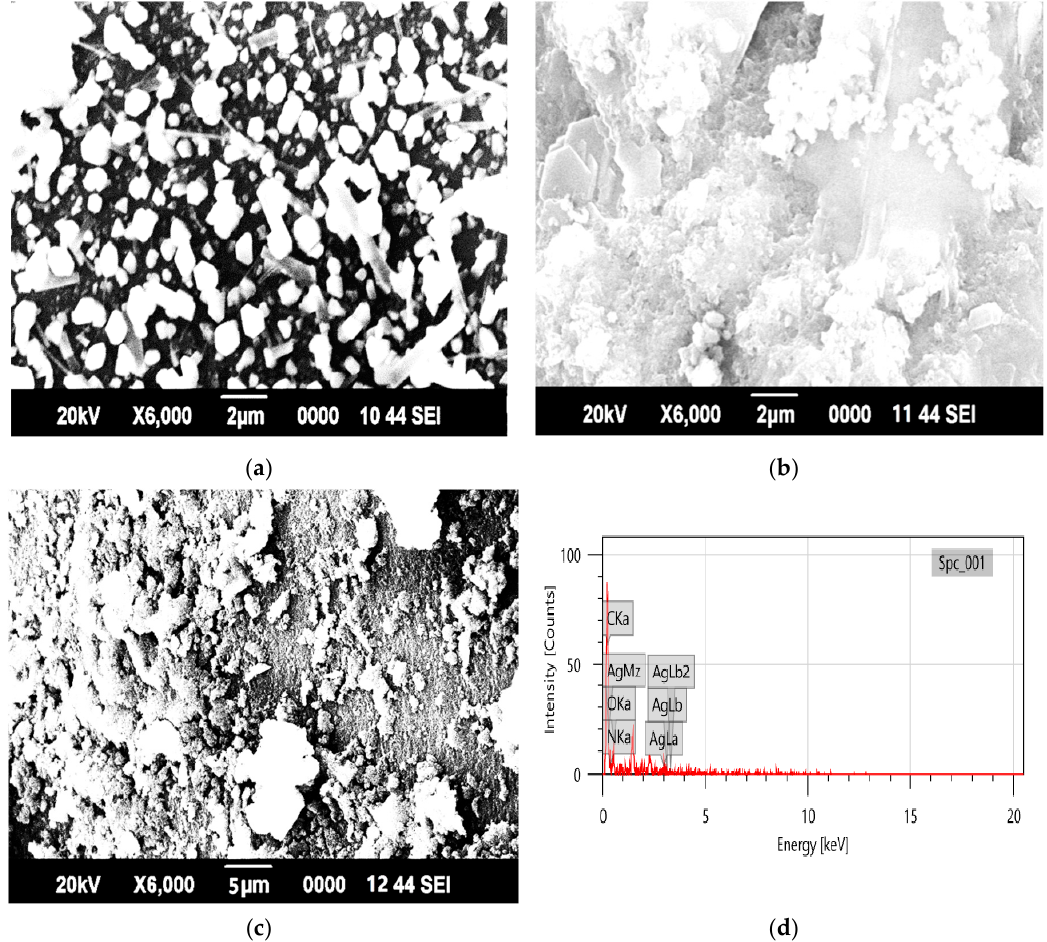
Figure 3. SEM images of: ( a ) sodium alginate; ( b ) poly(acrylonitrile); and ( c ) PAN-g-Alg@Ag. ( d ) The EDX spectrum of PAN-g-Alg@Ag.